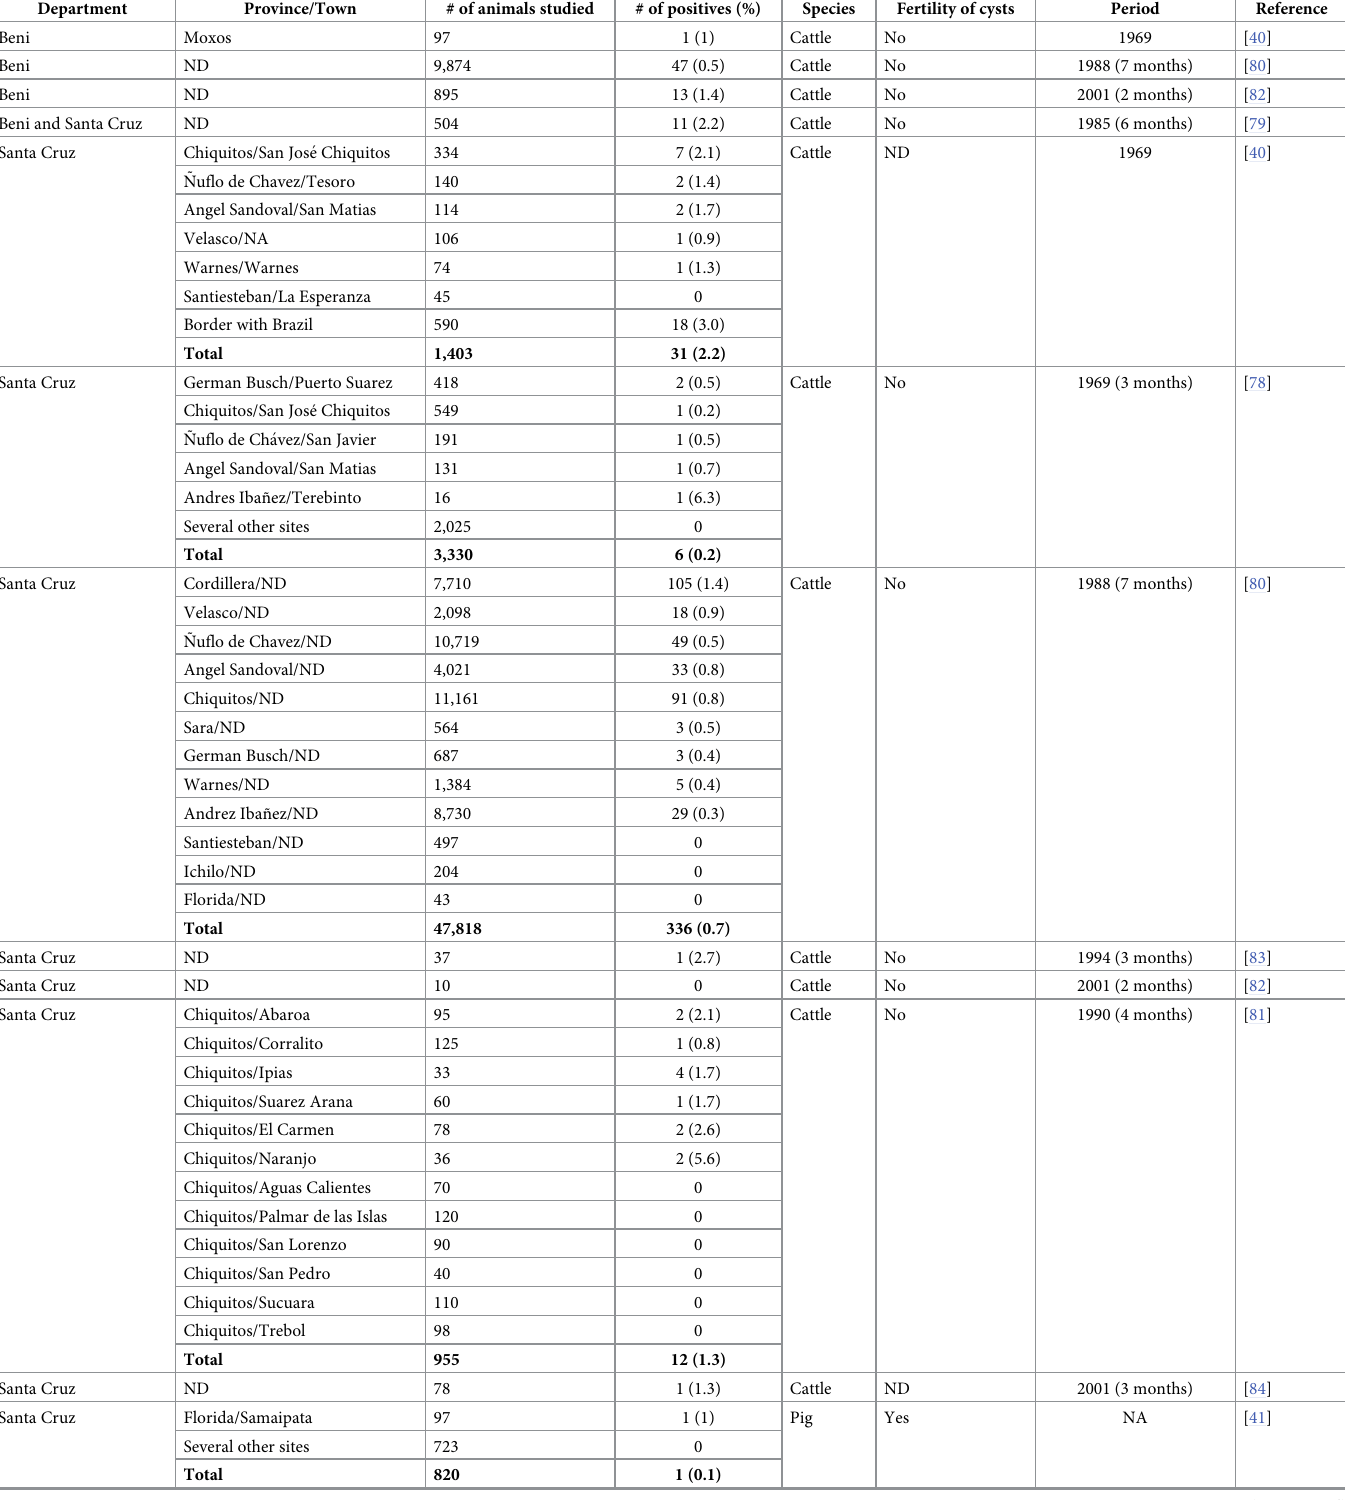
Table 4. Summary of reports of infection with E . granulosus in livestock species at postmortem examination at abattoir in the different departments and provinces of Bolivia.